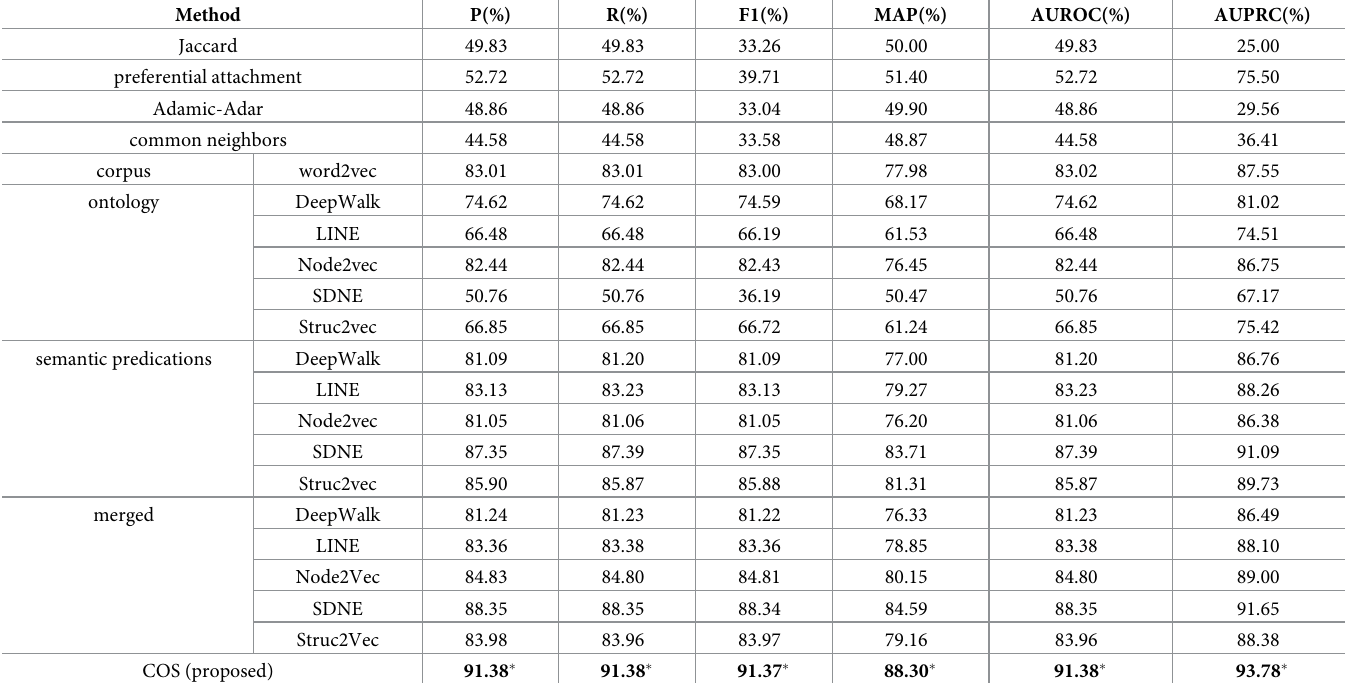
Table 4. Edge prediction results for